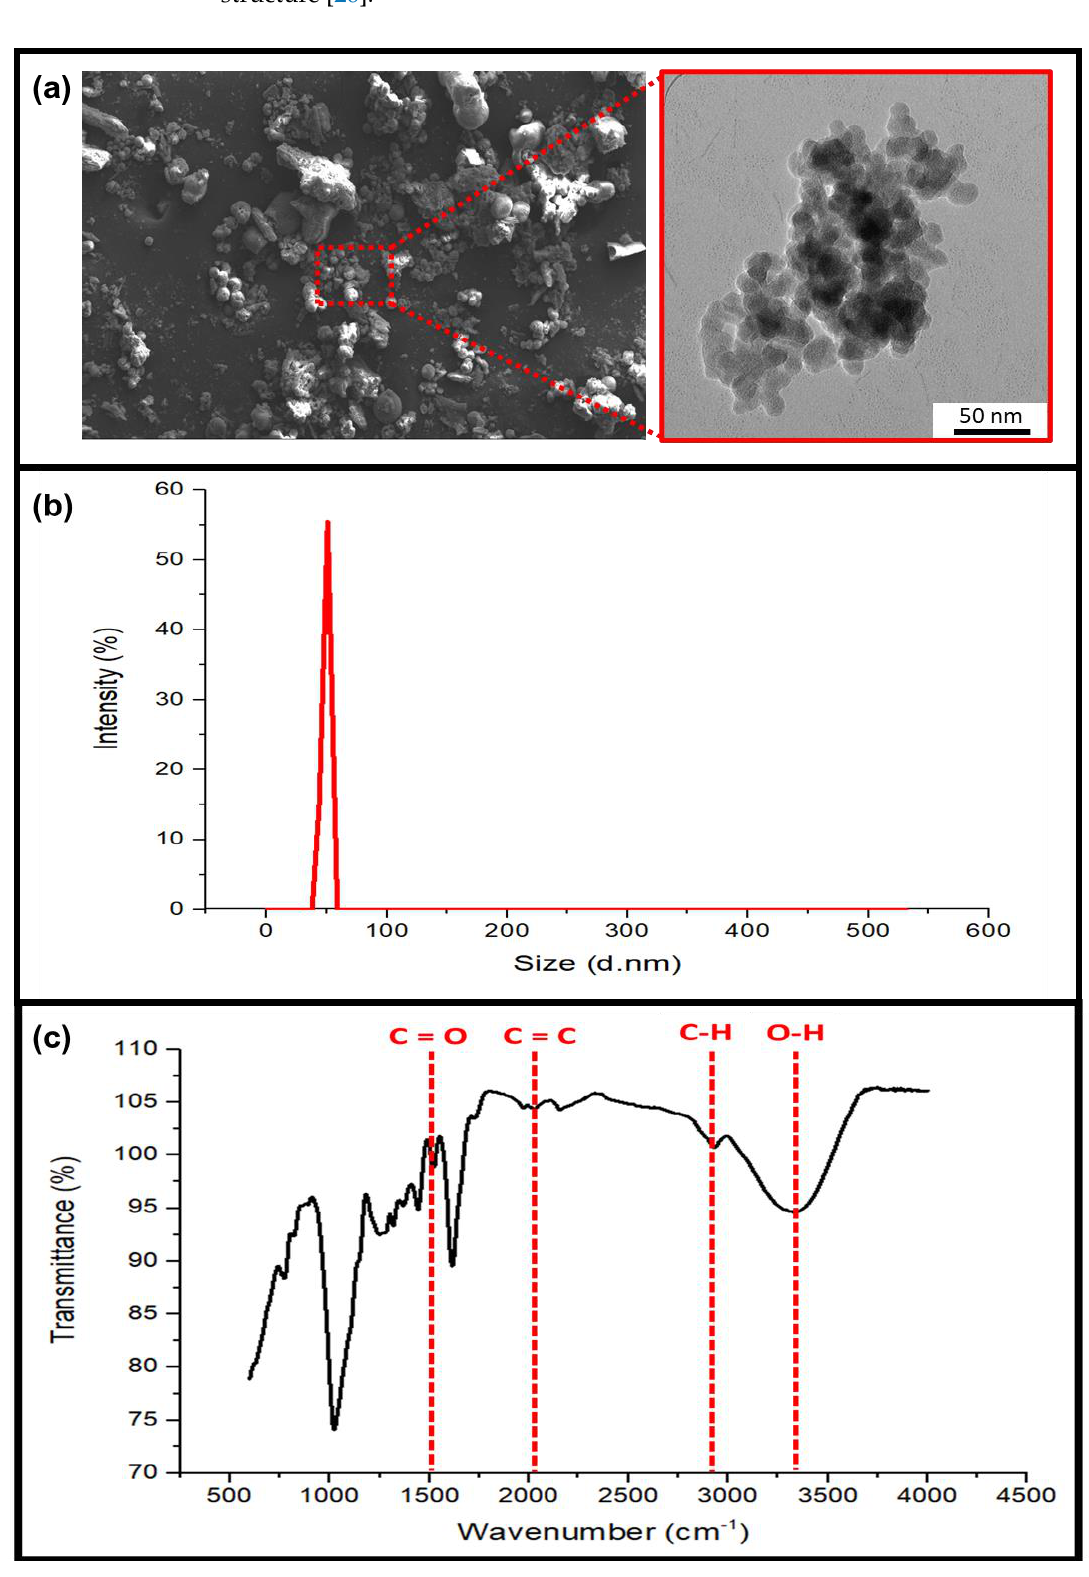
Figure 1. ( a ) SEM and TEM, ( b ) particle size distribution, and ( c ) FT-IR of cinnamon nanoparticles.